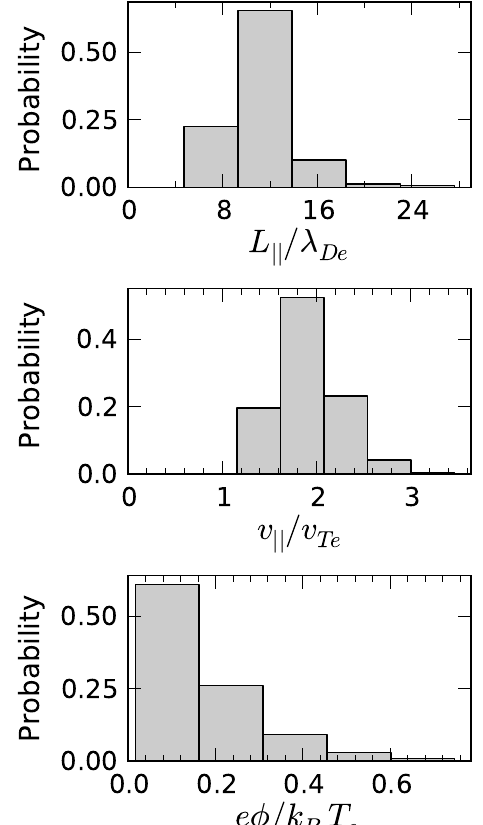
Fig. 4. Histograms of the probability of occurrence of the structure parallel half-widths (top), parallel velocities (middle) and electric potential amplitude